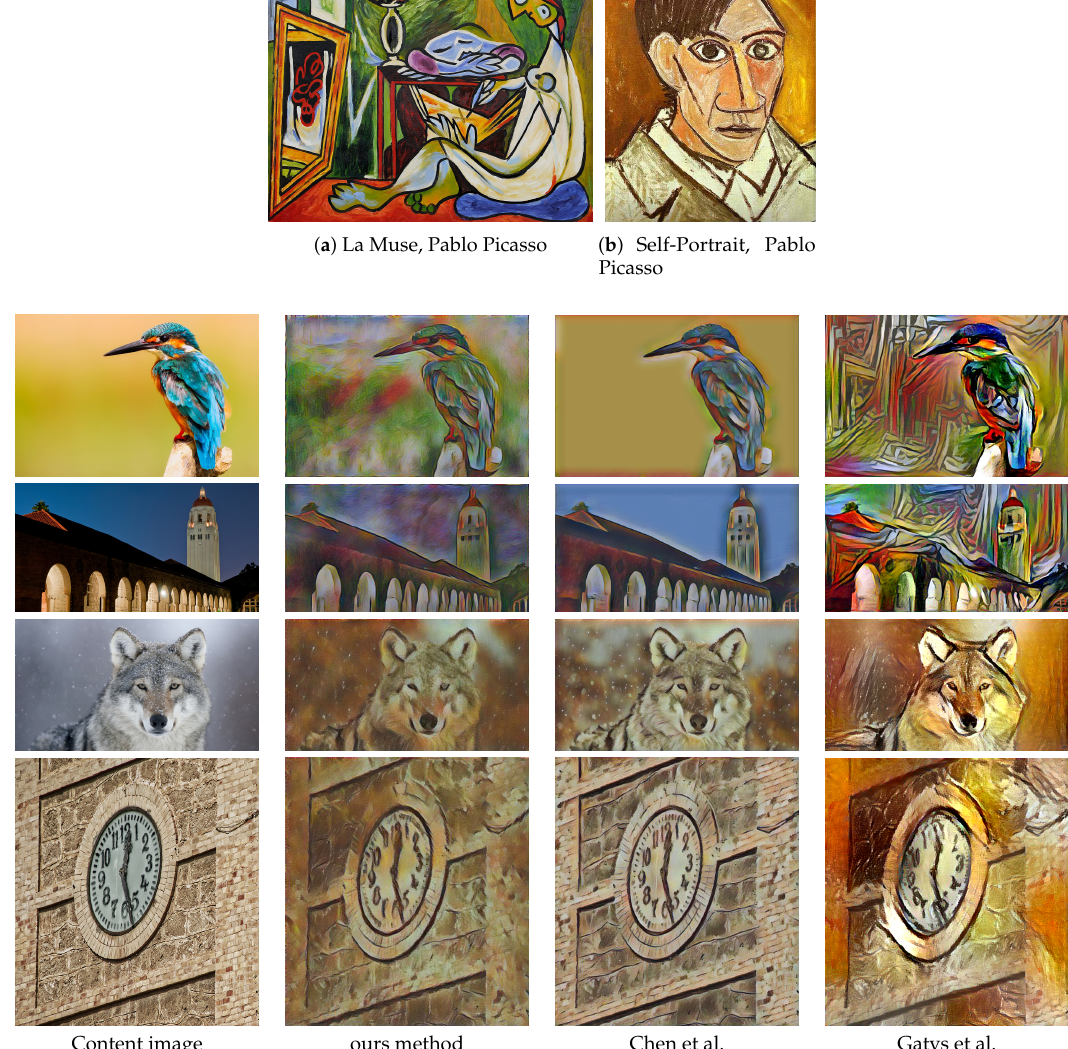
Figure 10. Comparisons.